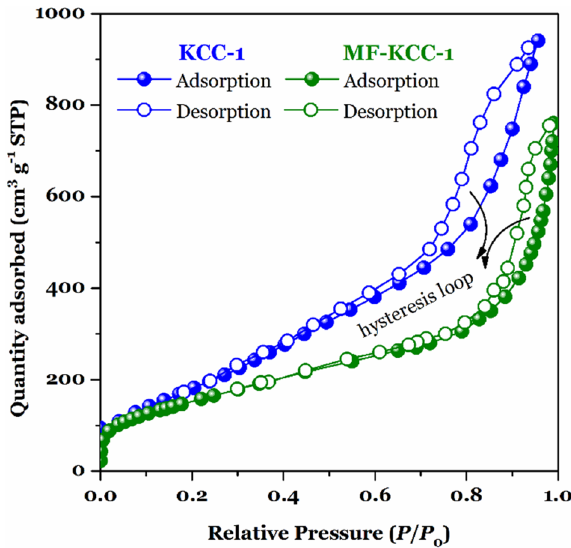
Figure 5. The N 2 adsorption–desorption isotherms of KCC-1 and MF-KCC-1.